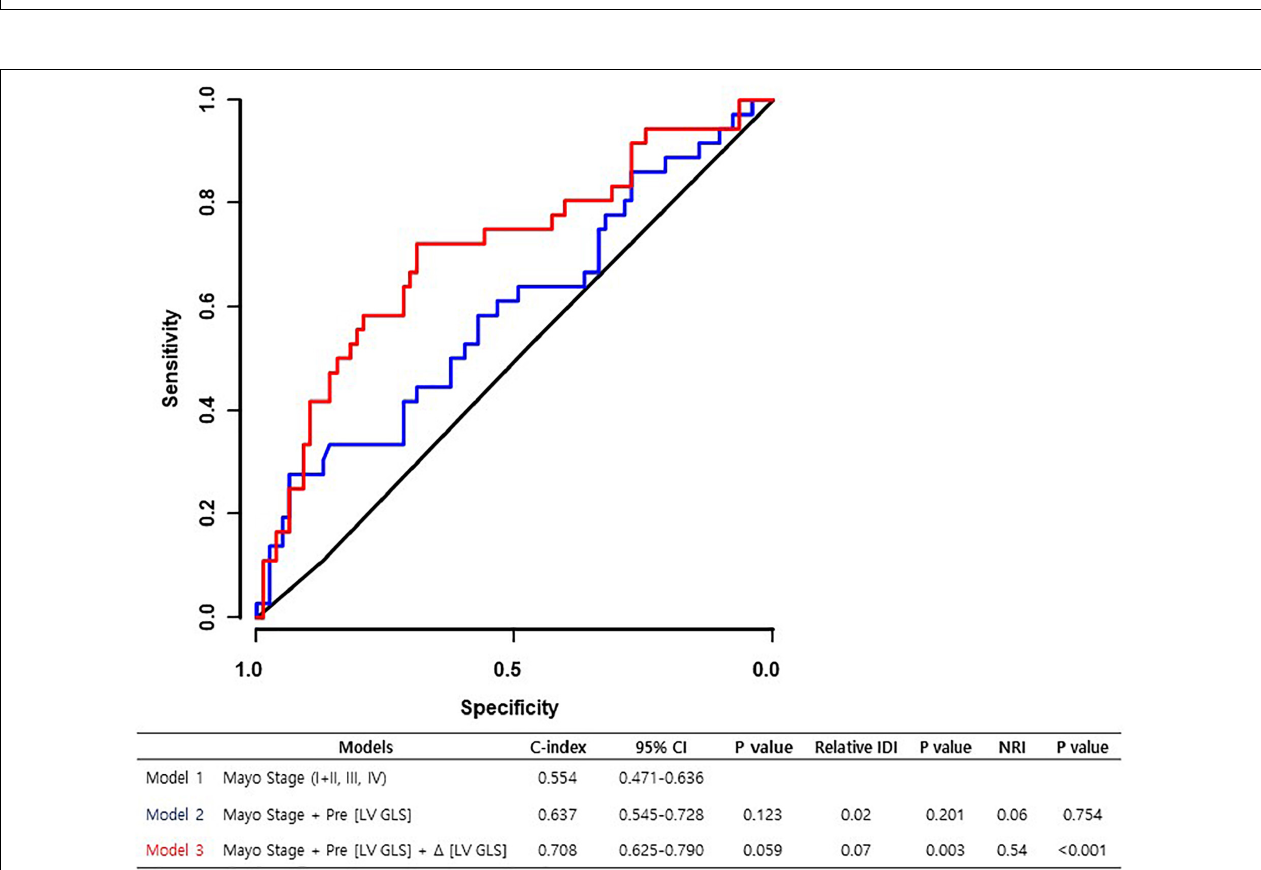
FIGURE 3 | Survival difference according to (cid:49) [LV GLS] after chemotherapy. CI, confidence interval; HR, hazard ratio; (cid:49) [LV GLS], post-chemotherapy [LV GLS]—pre-chemotherapy [LV GLS].